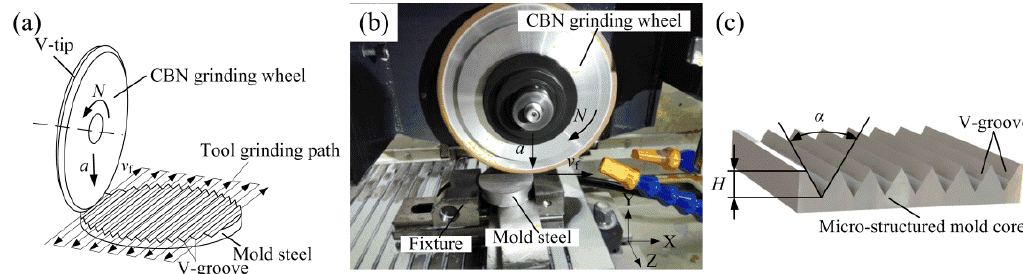
Figure 5. The precision grinding of the micro-structured mold core: ( a ) grinding principle and path; ( b ) experimental photo; ( c ) schematic diagram of the V-groove structure.